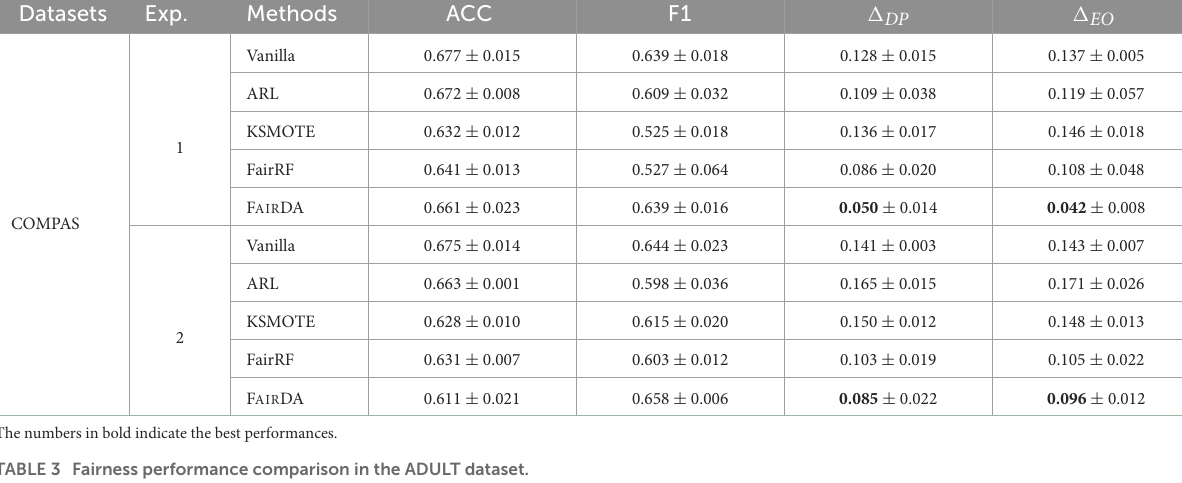
TABLE 3 Fairness performance comparison in the ADULT dataset. Datasets